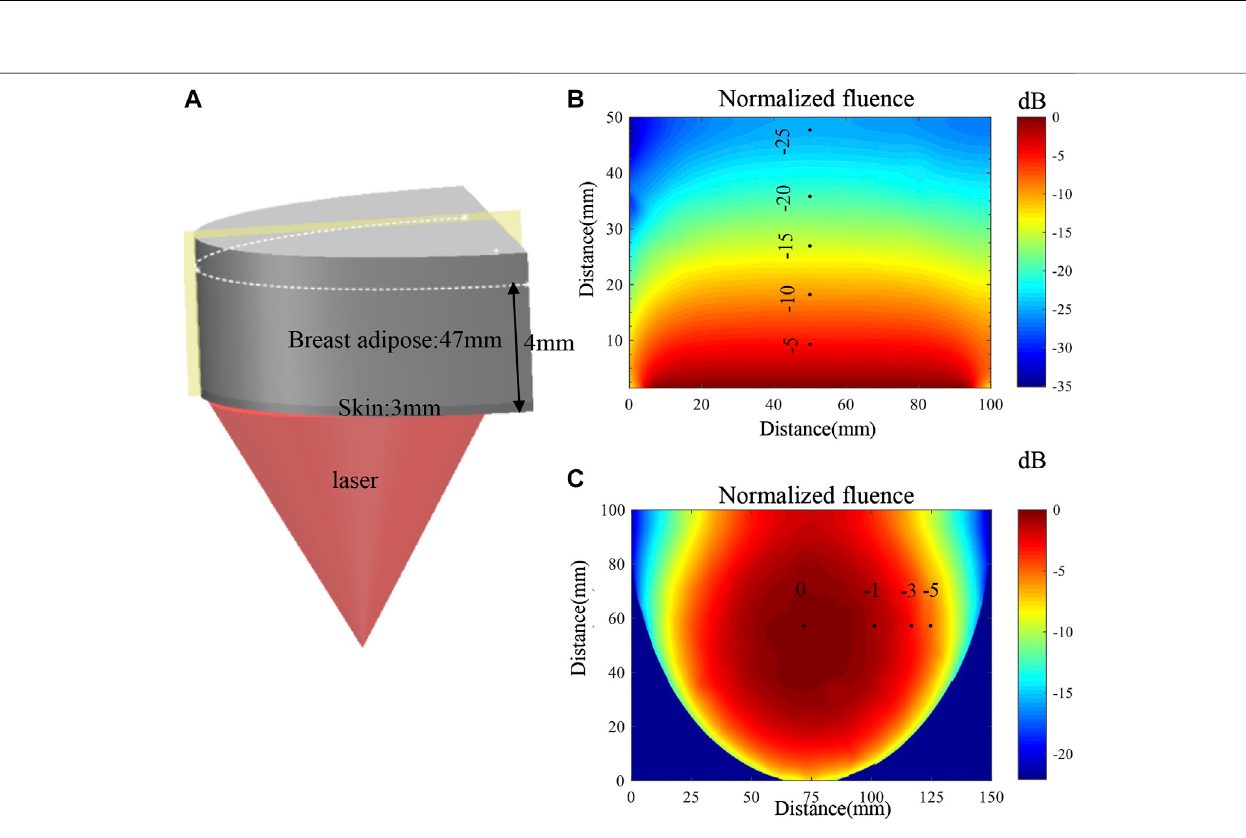
Frontiers in Physics |